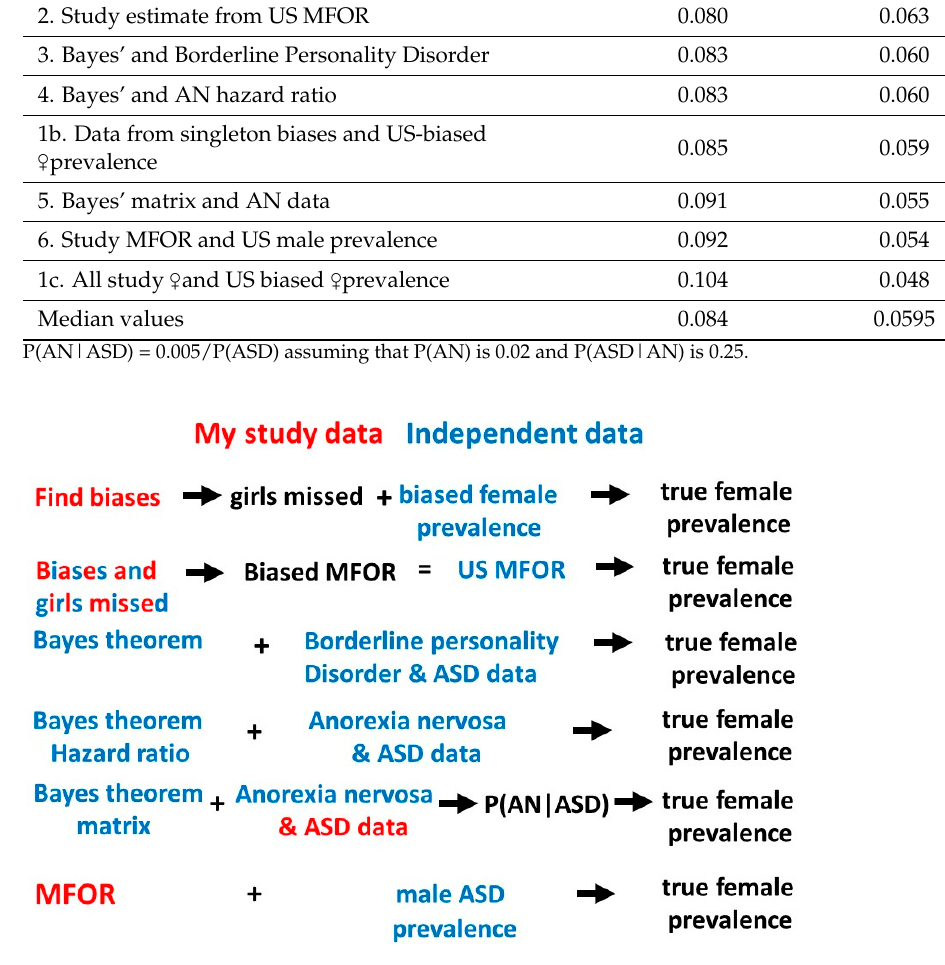
Figure 12. Pathways to the true female ASD prevalence.